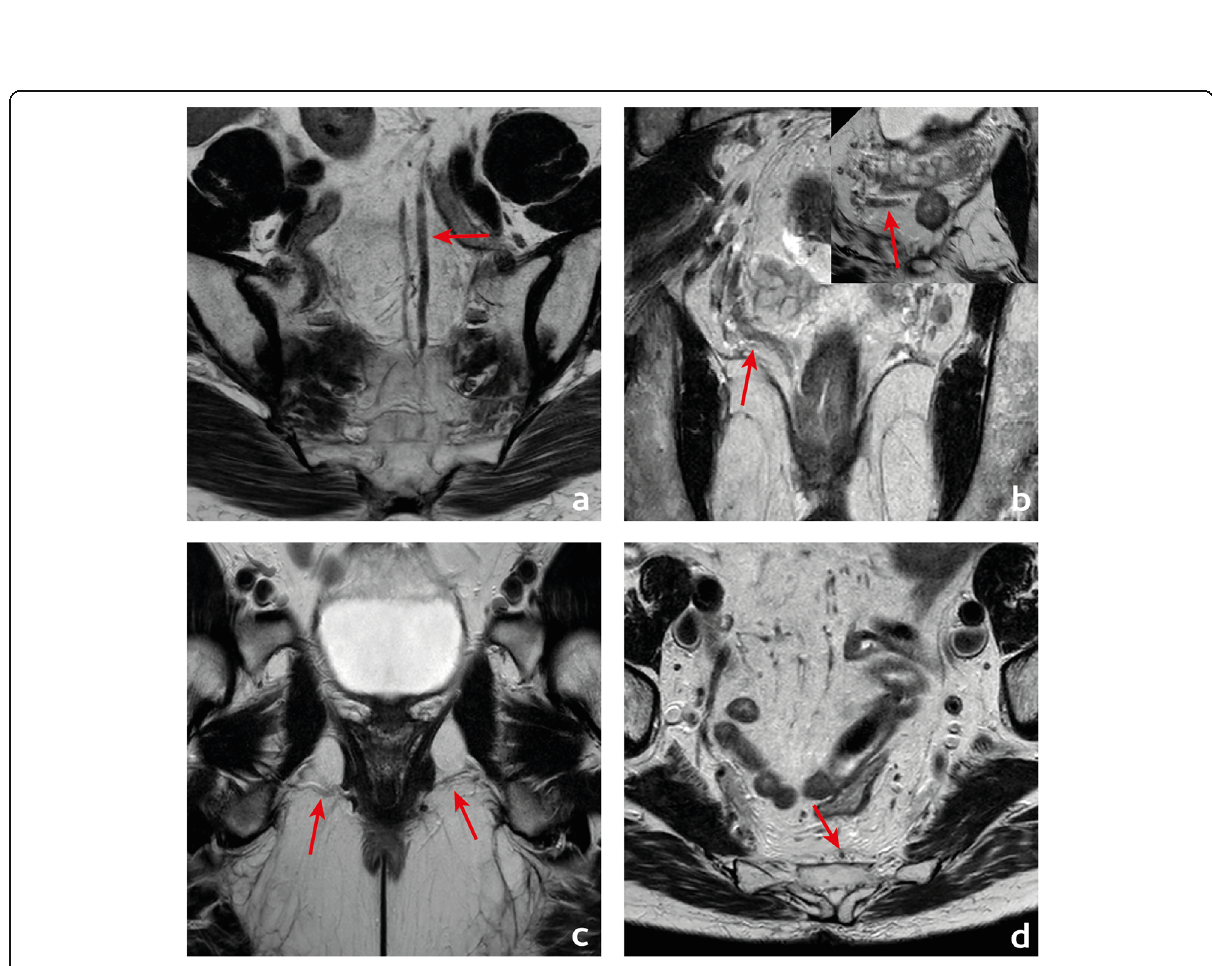
Fig. 7 The rectum ’ s arterial supply has 3 to 4 routes. The main route is the superior rectal artery (arrow in a ). The middle rectal arteries are inconsistent but may be present in up to 57% of cases. In b , a large calibre right middle rectal artery (arrow) arising from the internal iliac artery pierces the mesorectal fascia at its anterolateral aspect. The inferior rectal arteries originate from the internal pudendal arteries, are usually small in caliber and cross the ischioanal fossae towards the anal canal (arrows in c ). The middle sacral artery courses down along the lumbosacral vertebrae, within the presacral space (arrow in d